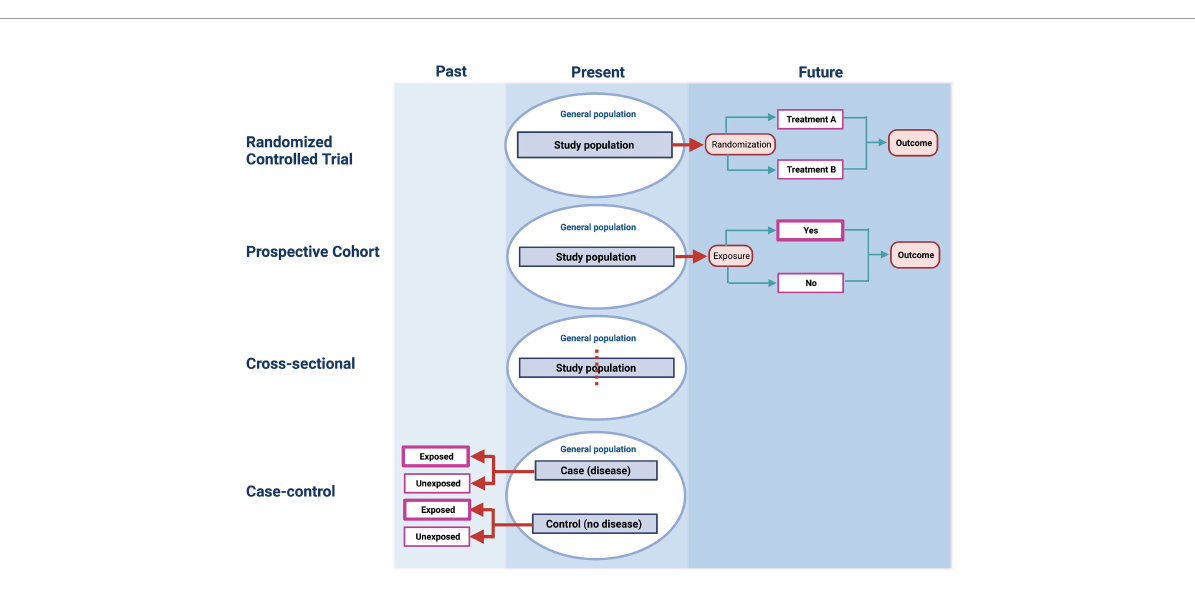
FIGURE 2 | The structure of different study